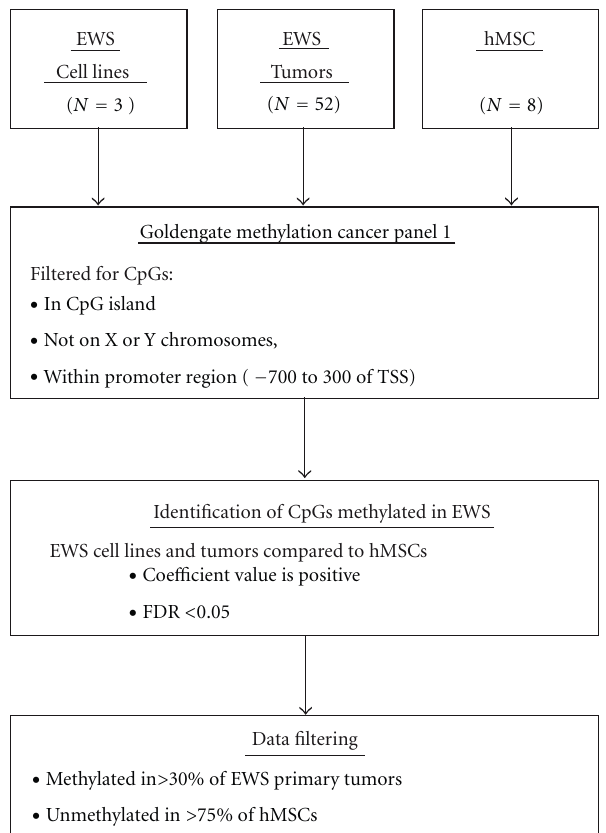
Figure 1: Flow chart describing workflow of DNA methylation